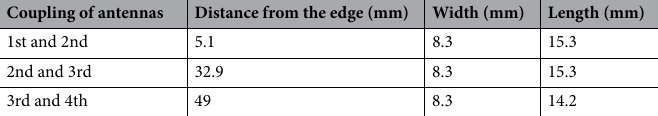
Table 1. Dimensions of the coupling slots.